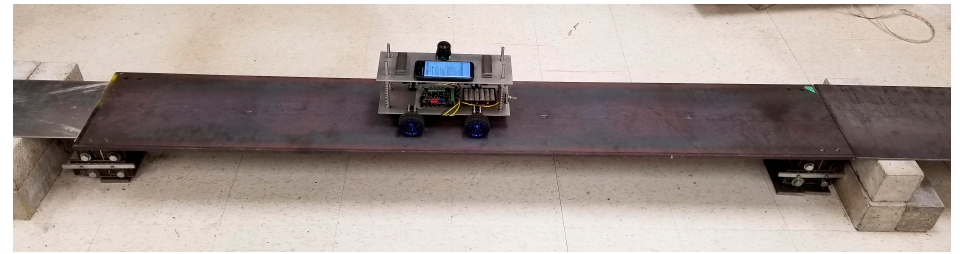
Figure 6. Simply supported bridge setup along with the instrumented robot vehicle.